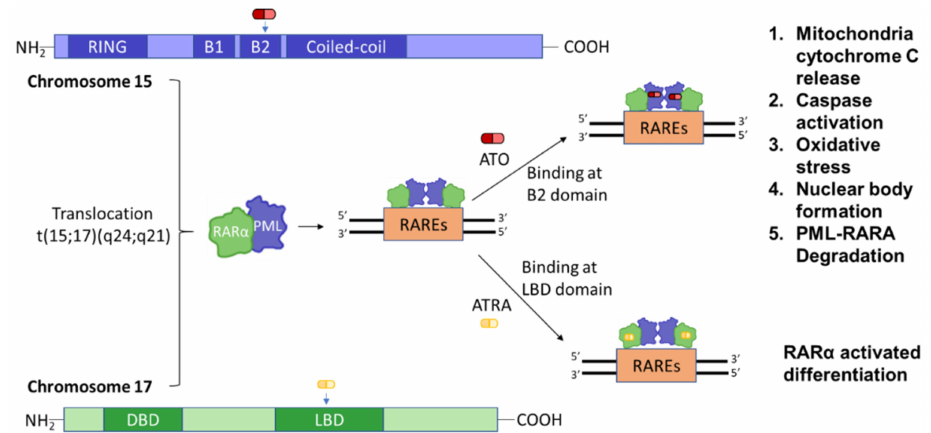
Figure 3. Synergistic effect of all-trans retinoic acid (ATRA) and arsenic trioxide (ATO) on PML::RARA. A translocation event results in the oncoprotein PML::RARA binding to RAREs (Retinoic Acid Response Element (RARE) Sequence). ATO binds to the B2 domain of PML and ATRA binds to the LBD domain of RARA, resulting in ta synergistic effect. DBD: DNA-binding domain; LBD: Ligand-binding